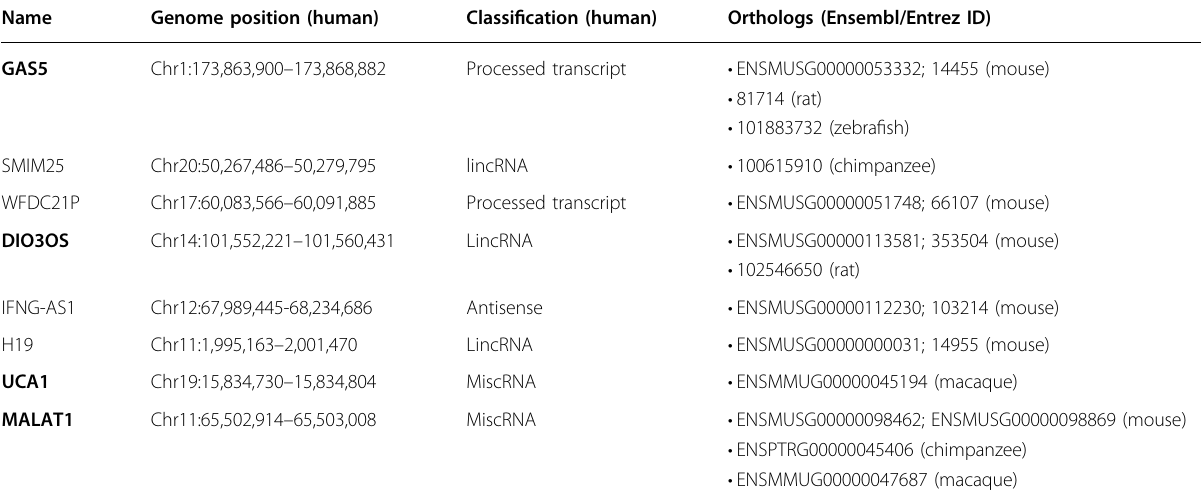
Table 3 List of lncRNAs that have orthologs in other organisms based on HCOP